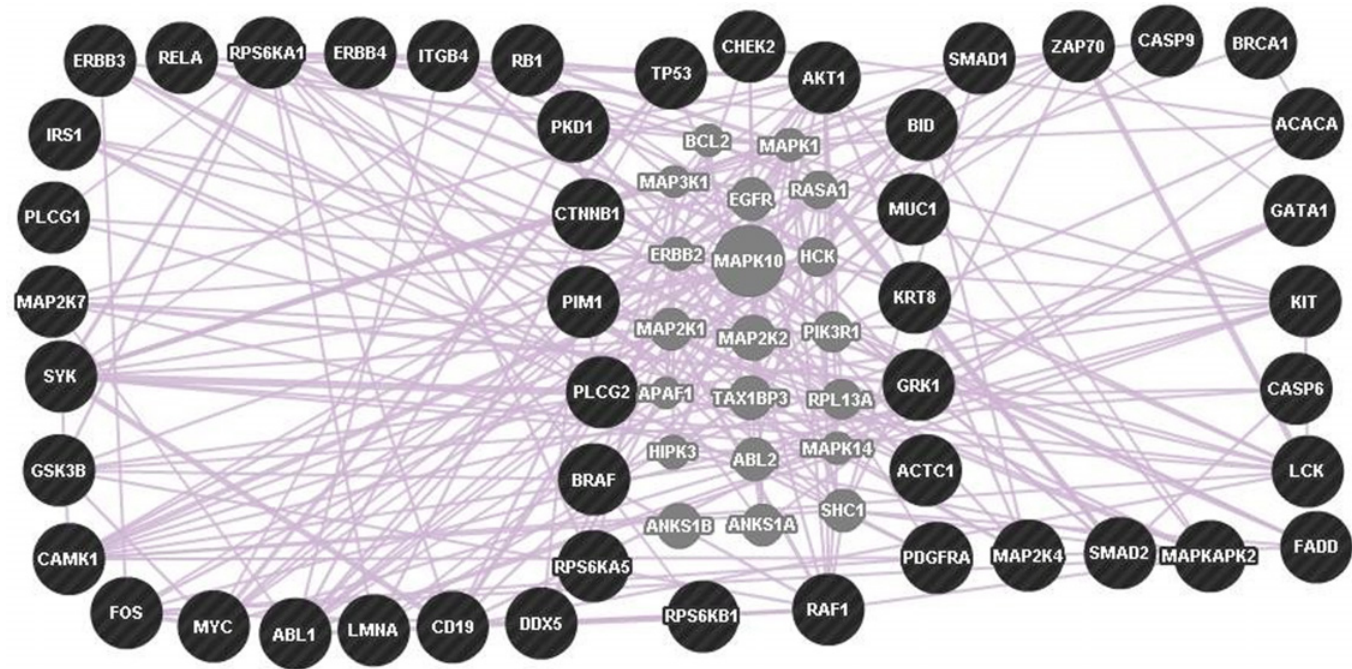
Fig 6. Co-expression gene network. A network of differential genes was generated using GeneMANIA. The left network represents up-regulated genes and the right network represents down-regulated genes. In addition, five genes exist in both the up- and down-regulated networks (TP53, CHEK2, AKT1, RPS6KB1, RAF1). Query genes are indicated by black dots and co-expression is indicated by pink lines. Gray nodes indicate predicted genes.